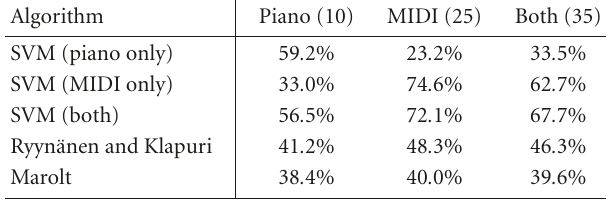
Table 2: Classification accuracy comparison for the MIDI test files and live recordings. The MIDI SVM classifier was trained on the 92 MIDI training excerpts, and the Piano SVM classifier was trained on the 20 piano recordings. Numbers in parentheses indicate the number of test excerpts in each case.